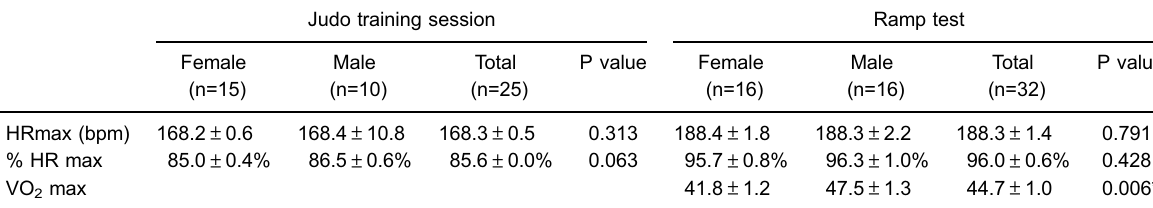
Table 2. Physiological pro fi les of the groups for the judo training session and ramp test.